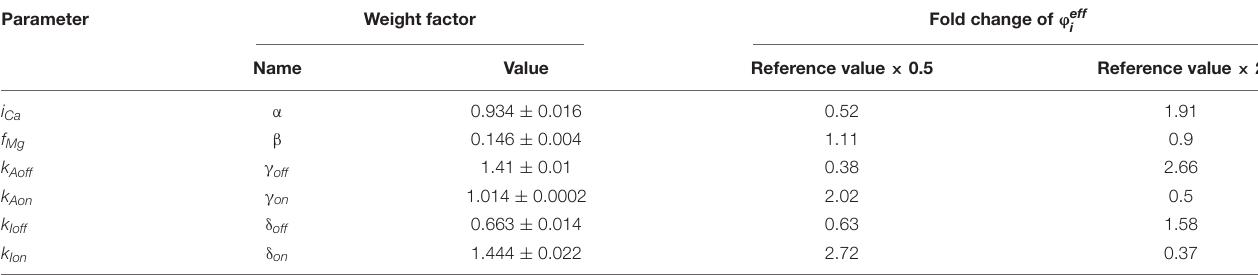
TABLE 3 | Parameters and weight factors of the effective coupling strength. Parameter Weight